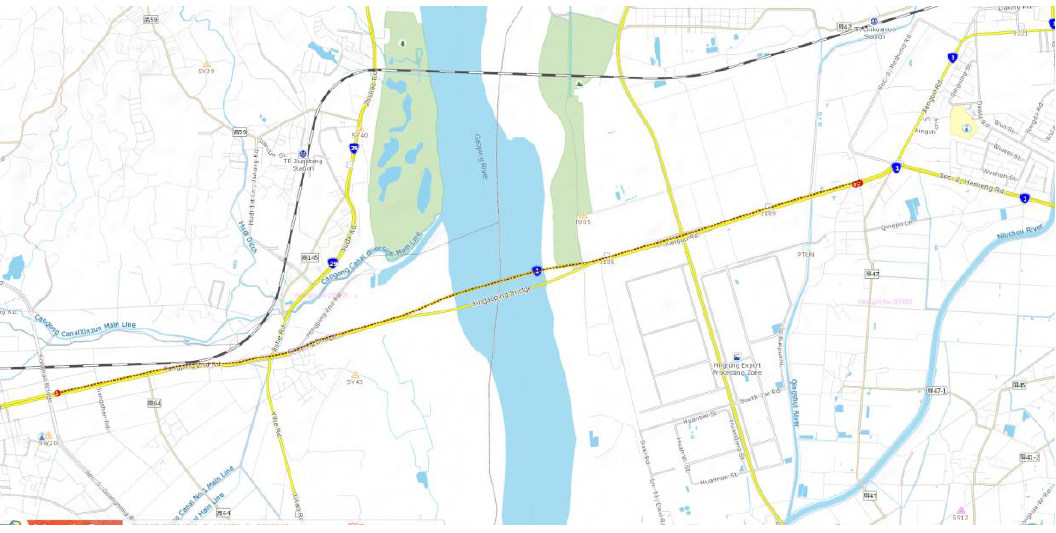
Figure 5. The urban road segments in the experimental environment.